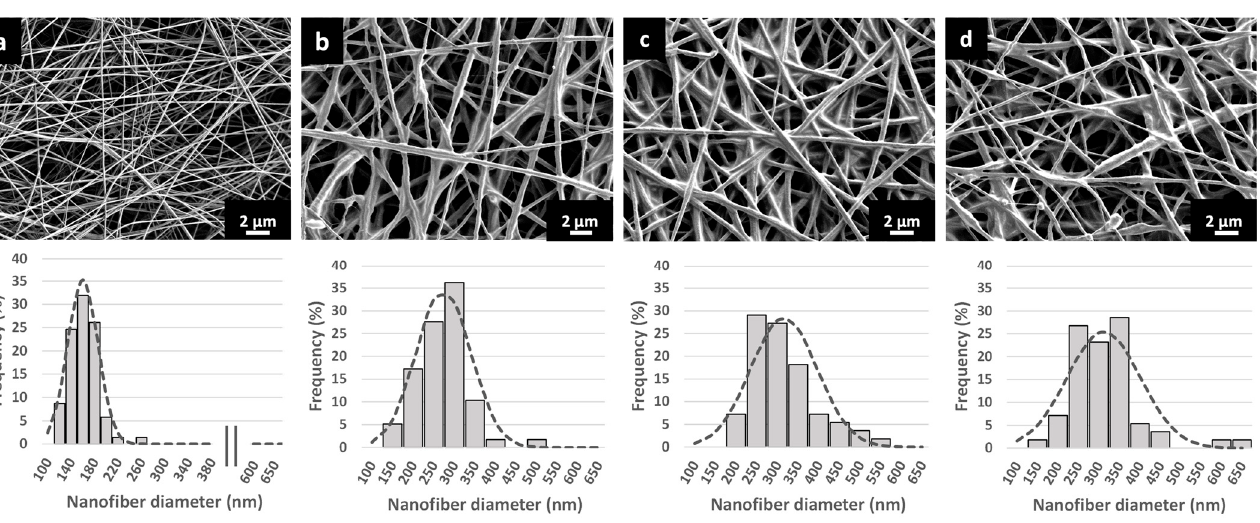
Table 2. Characterization of the nanofibrous samples in terms of the average nanofiber diameter (nm), drug loading (DL, % w / w ), and drug loading efficiency (DLE, %). Small letters indicate couples of statistically different